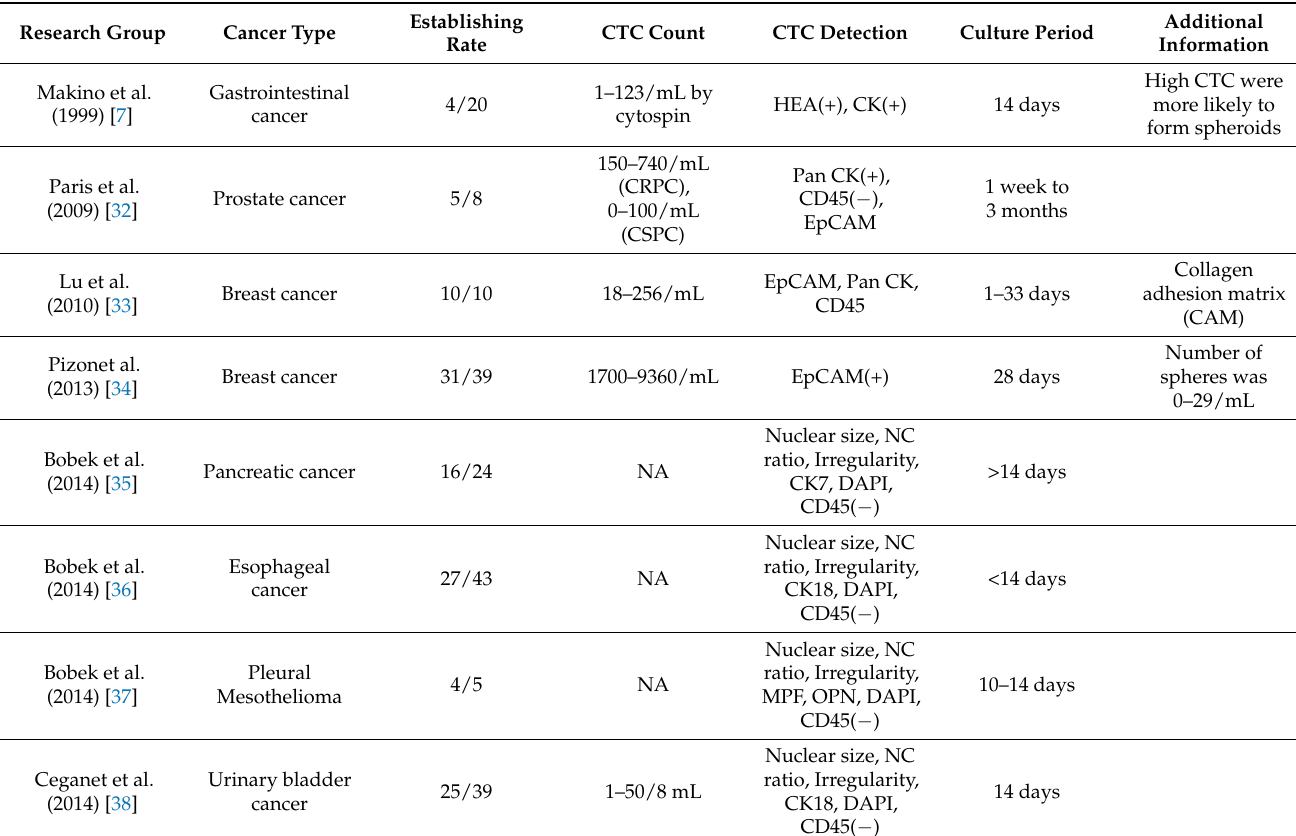
Table 3. Summary of short-term